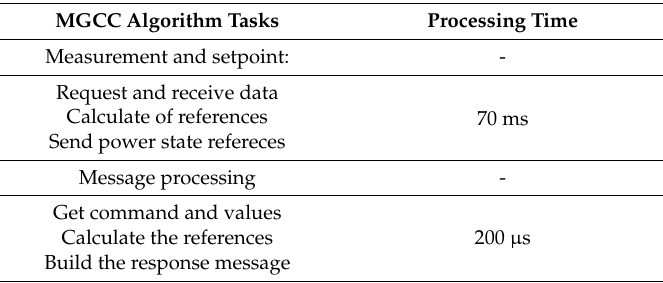
Table 4. Processing time used by the algorithms on the MGCC.